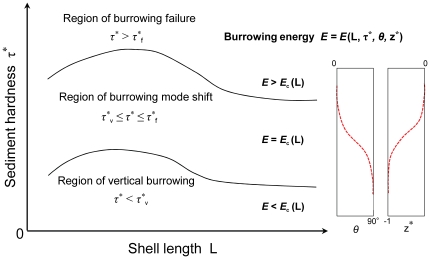
Energy-based conceptual model to account for the three distinctive burrowing regions for Ruditapes philippinarum and Donax semigranosus.For the bivalve with an individual traits, E denotes the required burrowing energy as a function of the shell length L, sediment hardness τ*, burrowing angle θ and normalized burrowing depth z*. E
c (L) denotes the burrowing capacity of the bivalve at a given growth stage. τ*v represents the burrowing criteria below which the bivalve accomplishes vertical burrowing. τ*f represents the burrowing criteria above which the bivalve fails to burrow.